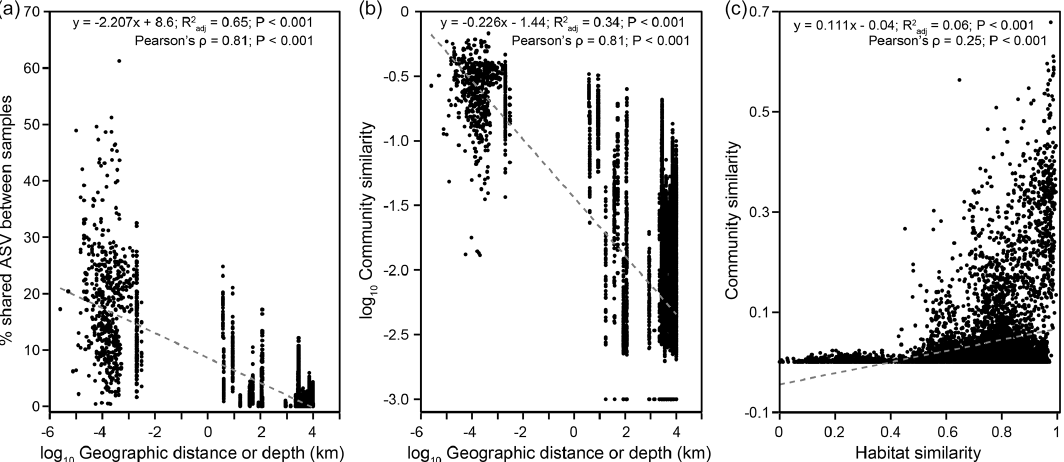
Figure 5. Biogeographic patterns for MV microbial communities. Plots of (a) the proportion of shared ASV and (b) the community similarity versus geographic distance or depth, and a plot of (c) the community similarity versus habitat similarity based on pairwise comparison for a total of 126